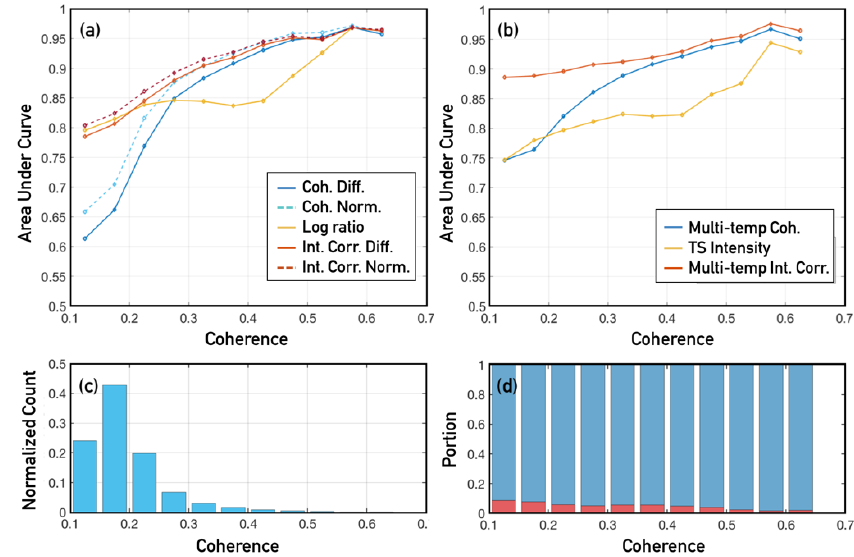
Figure 9. AUCs of ROC curves as a function of coherence level for ( a ) quick-product and ( b ) multi-temporal approaches. A 0 represents chance performance, while 1 represents perfect performance. ( c ) Histogram of coherences over the study area. ( d ) Bar graph showing the portion of landslide (red) and non-landslide (blue) areas for the coherence levels.